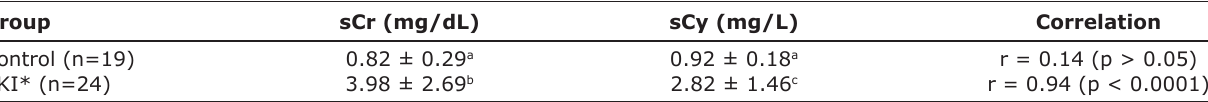
Table-2: Means, standard deviations, and correlations between sCr and sCy of dogs in the control group and in the AKI group. Group sCr (mg/dL) sCy (mg/L) Control (n=19)